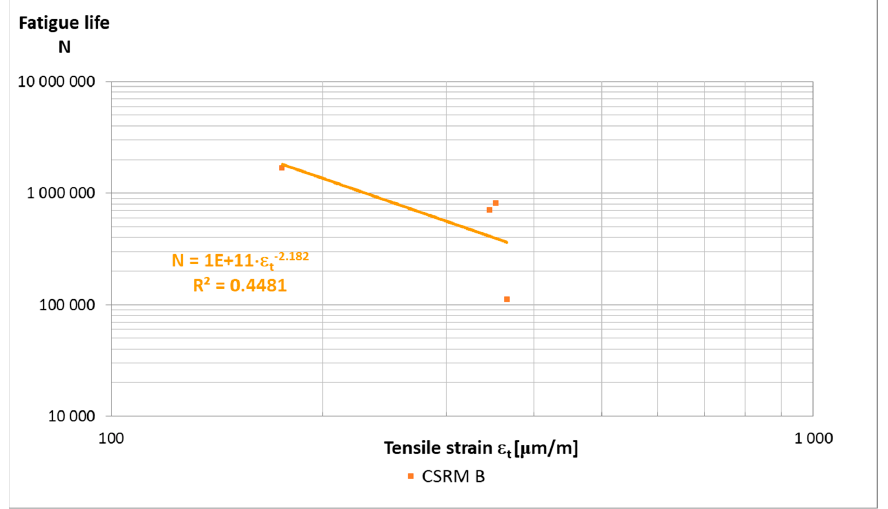
Figure 5. Fatigue life of 380 mm × 63 mm × 50 mm beams made of “B” mortar at 10 °C, after 28 days of curing.